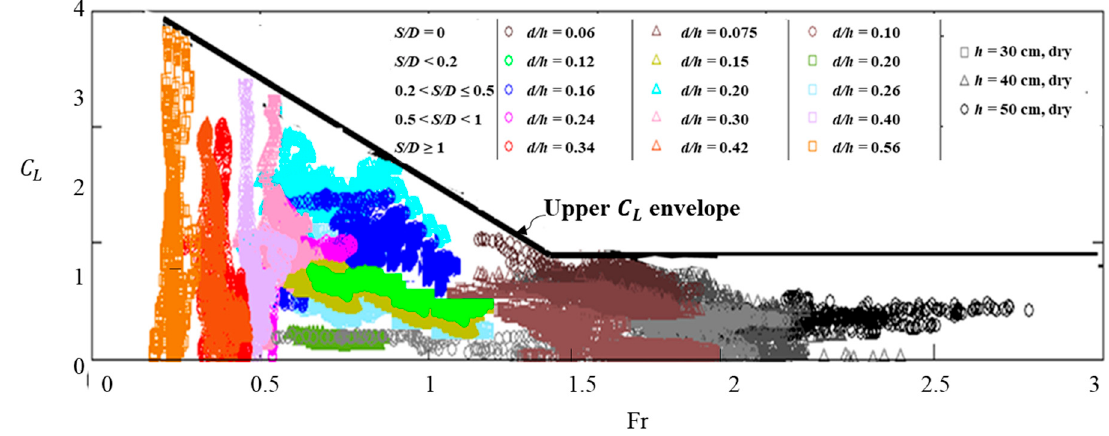
Figure 11. Maximum calculated lift coefficients versus Froude numbers for all the experiments conducted in this